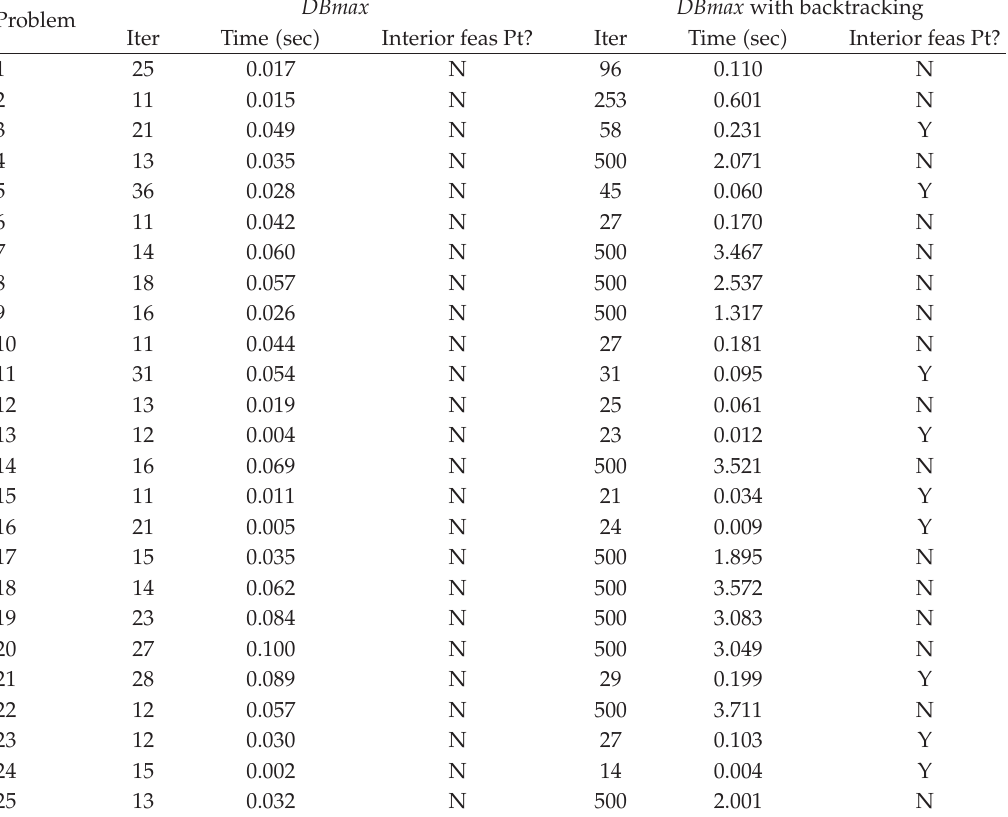
Table 7: CQCs: comparison of DBmax method and DBmax method with